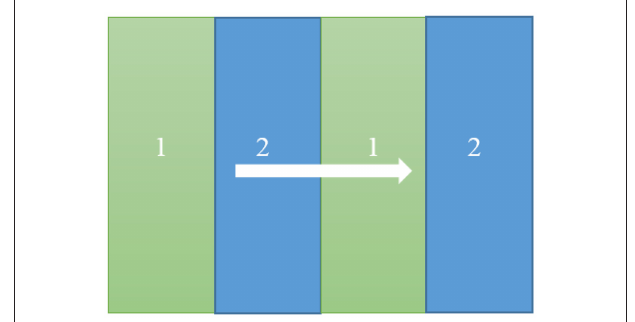
FIGURE 1 | Schematic of cross-plane interfacial phonon transport through a four-layer thin film, 1 and 2 denote two dissimilar materials as 1(Si) and 2(Ge) or 1(Ge) and 2(Si),